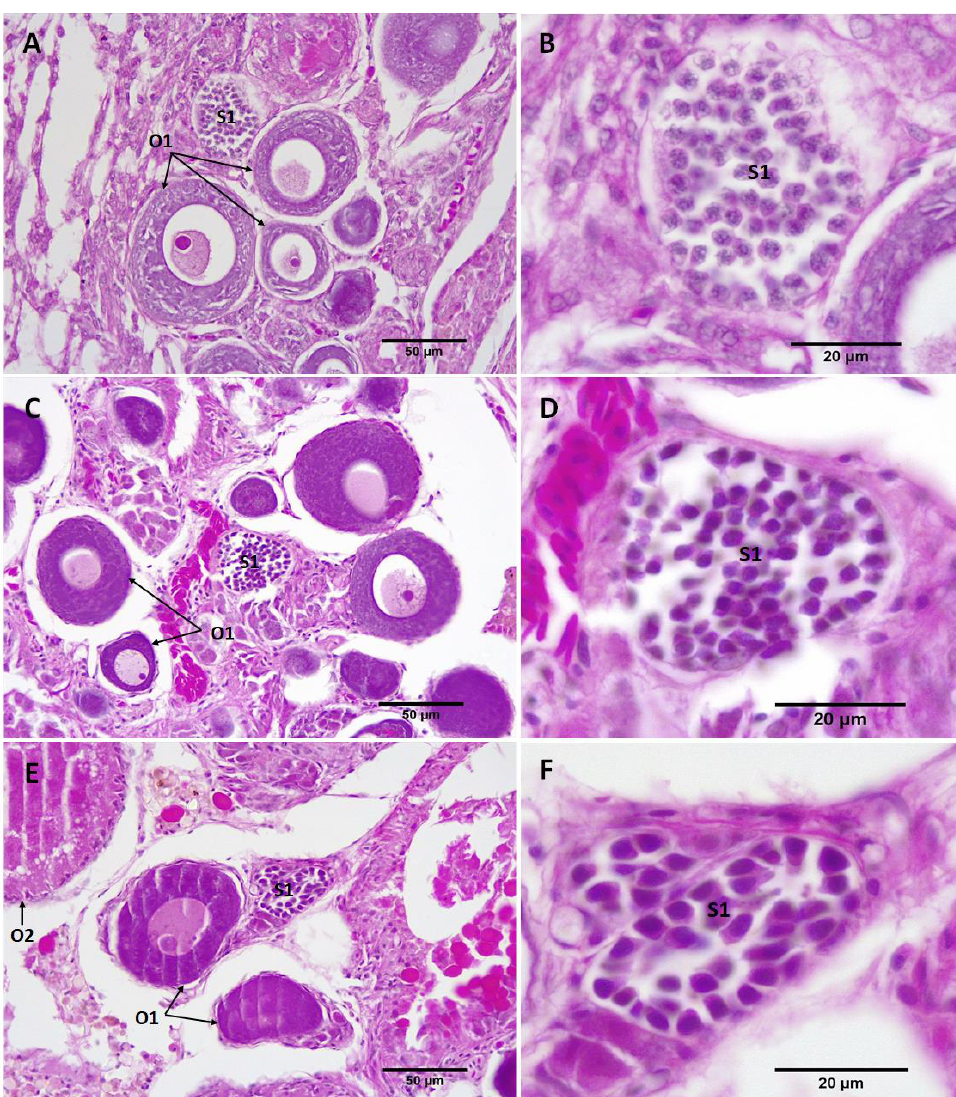
Figure 6. Sagittal sections through the gonads of MT-treated RG females showed the presence of primary spermatocytes in the ovary of MT-treated females. ( A ) The gonad of the female fed with 50 mg MT/kg diet and ( B ) its spermatocyte cyst at higher magnification; ( C ) gonad of the female fed with 75 mg MT/kg diet and ( D ) its spermatocyte cyst at higher magnification; and ( E ) gonad of the female fed with 150 mg MT/kg diet and ( F ) its spermatocyte cyst at higher magnification. O1: primary oocytes, O2: cortical alveoli oocytes, S1: primary